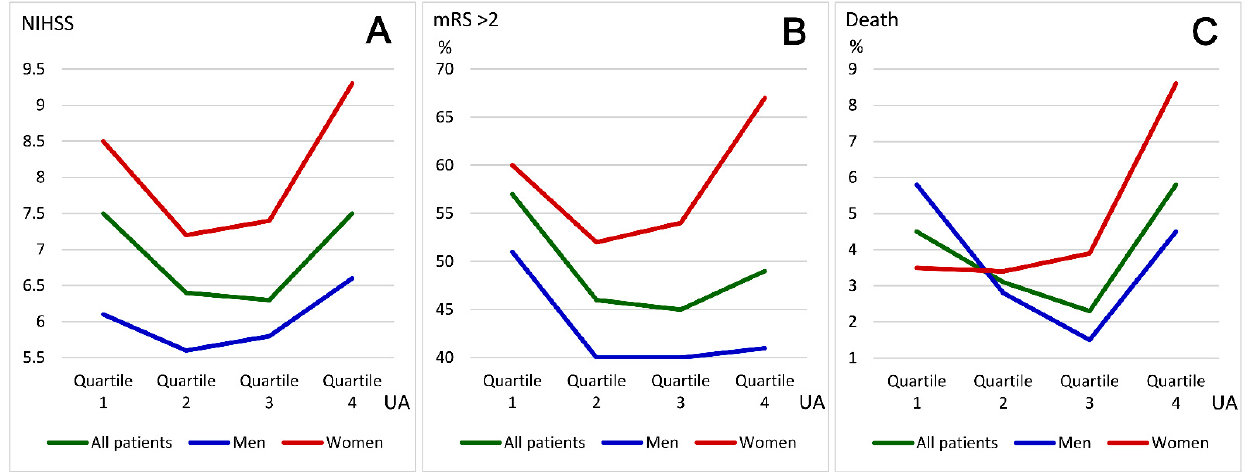
Figure 3. ( A ) Distributions of the average NIHSS scores according to the quartiles of uric acid in all patients, men, and women. ( B ) Distributions of the percentage of unfavorable outcomes (discharge modified Rankin Scale score > 2) according to the quartiles of uric acid in all patients, men, and women. ( C ) Distributions of the percentage of death according to the quartiles of uric acid in all patients, men, and women. The percentages of unfavorable outcomes and death were highest in men within Quartile 1 of uric acid, and were highest in women within Quartile 4 of uric acid. Ranges of uric acid levels in Quartiles 1 to 4 are <4.1 mg/dL, 4.1–5.1 mg/dL, 5.1–6.2 mg/dL, and >6.2 mg/dL, respectively; mRS, modified Rankin Scale.